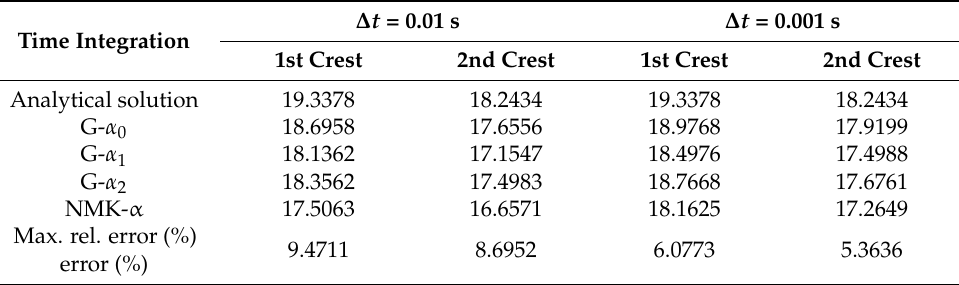
Table 3. Comparisons of crest deformation using the referred algorithms. Time